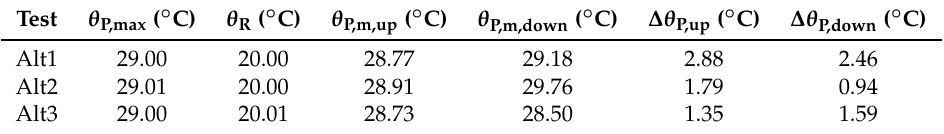
Table 2. Experimental results of surface temperature.